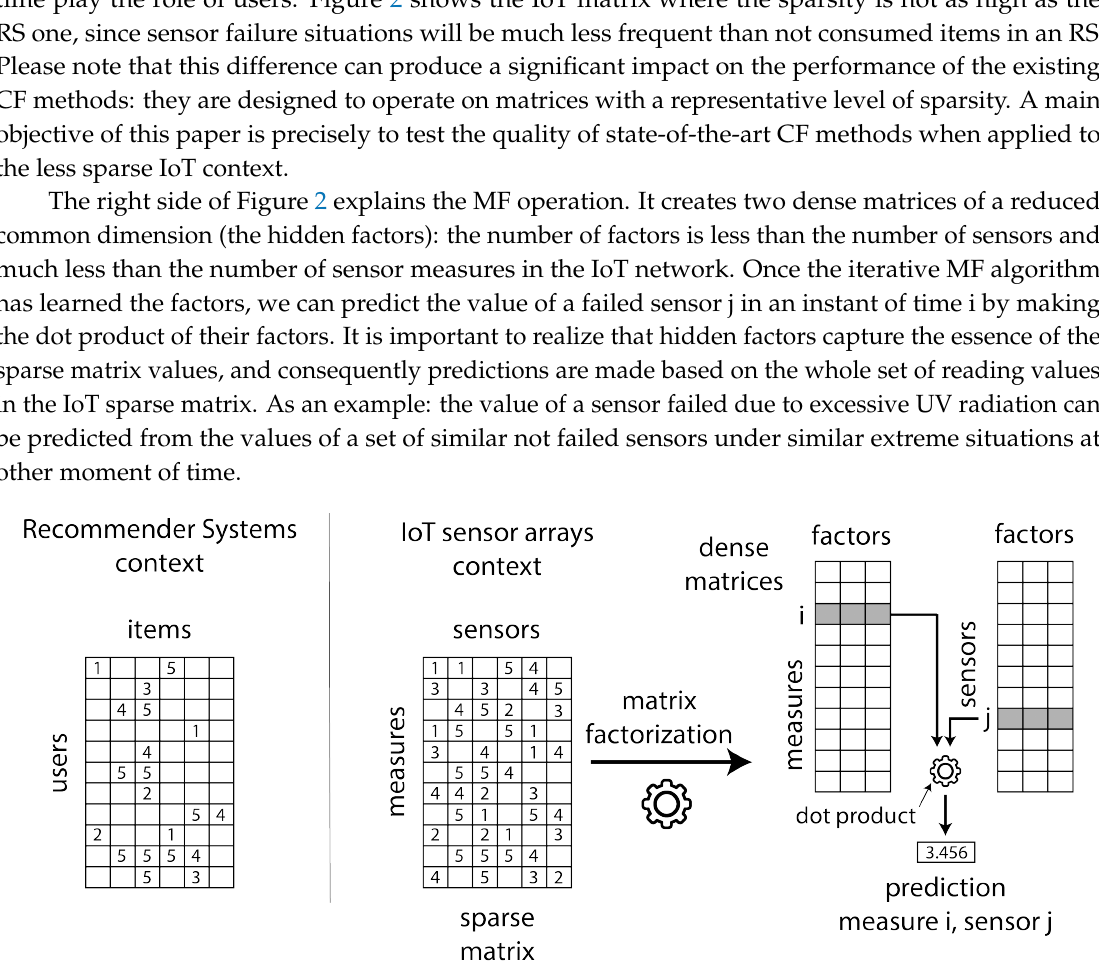
Figure 2. Collaborative filtering operation in the IoT sensor arrays